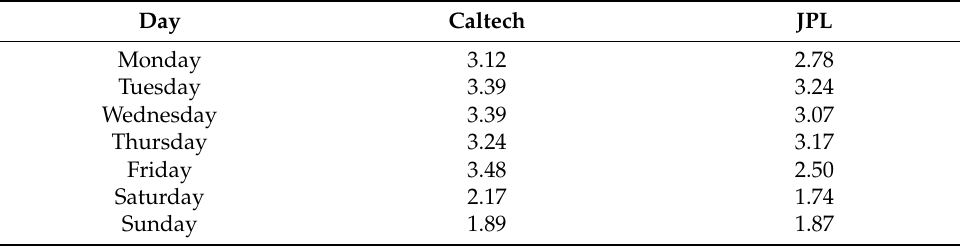
Table 4. Correlation score of historical power delivered.